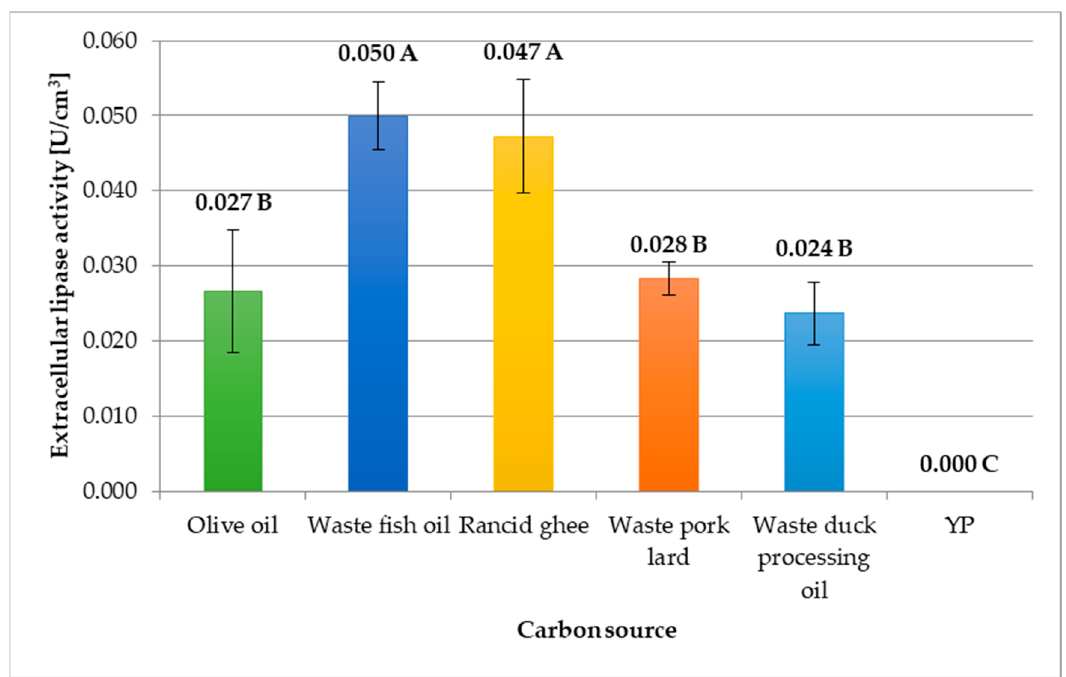
Figure 2. Effect of lipid-rich wastes on the extracellular lipase activity of C. cylindracea DSM 2031 after 65 h cultures. YP—control medium (10 g/L yeast extract (Y), 20 g/L peptone (P), pH = 5). Means with the same letter did not differ significantly ( α < 0.05).